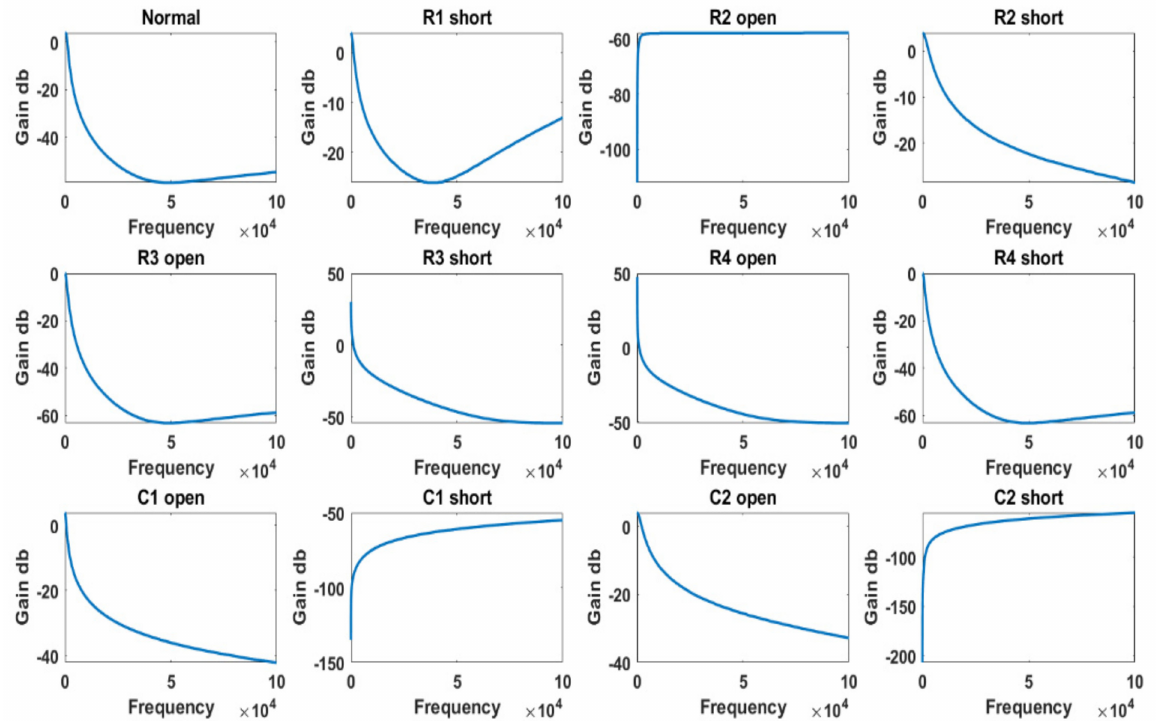
Figure 4. The frequency response of the LPF circuit for different fault categories.